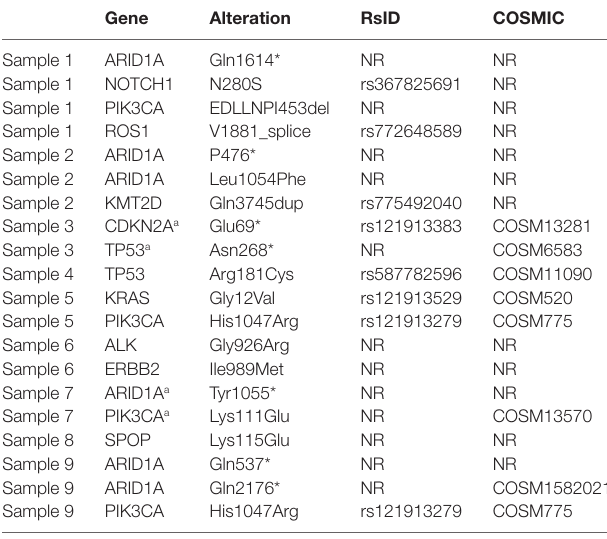
TaBle 4 | somatic variants in ovarian clear cell carcinoma and their reported rsiD and status in the cOsMic database. gene alteration rsiD